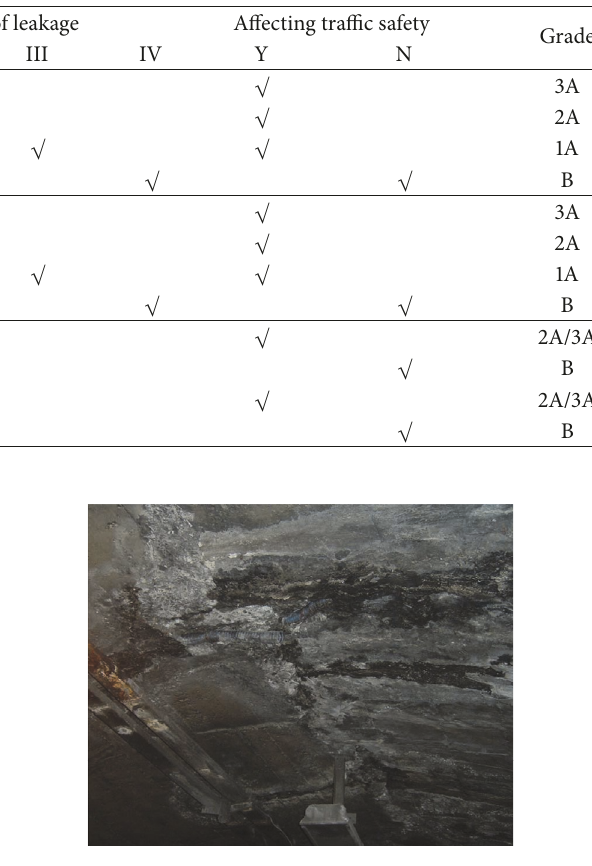
Figure 6: Leakage on vault of left